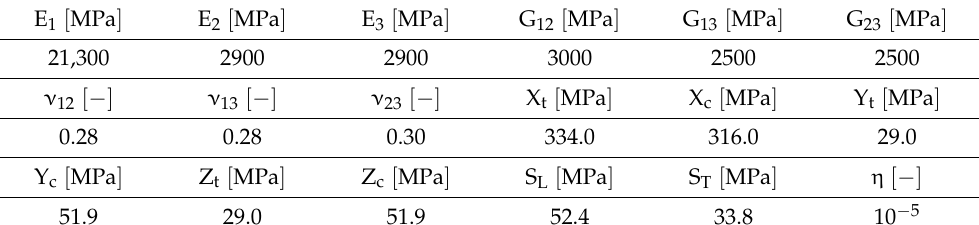
Table 5. Material properties for the pultruded GFRP material used in the double-lap tests.